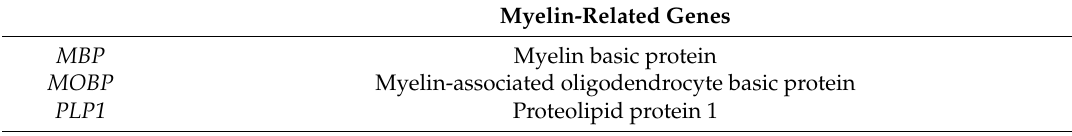
Table 3. List of functionally-relevant genes that co-express with NDRG1 in spinal cord periplaque